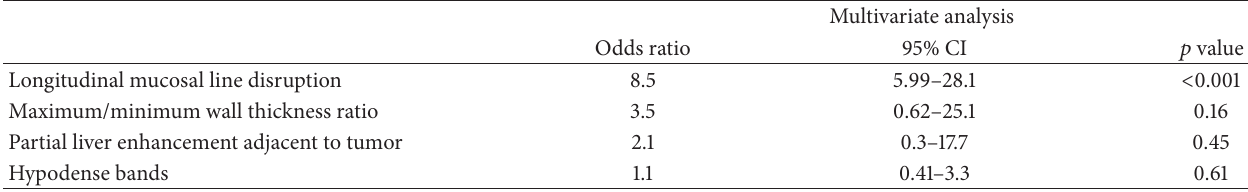
Table 4: Multivariate analysis of diagnosis on MPR image